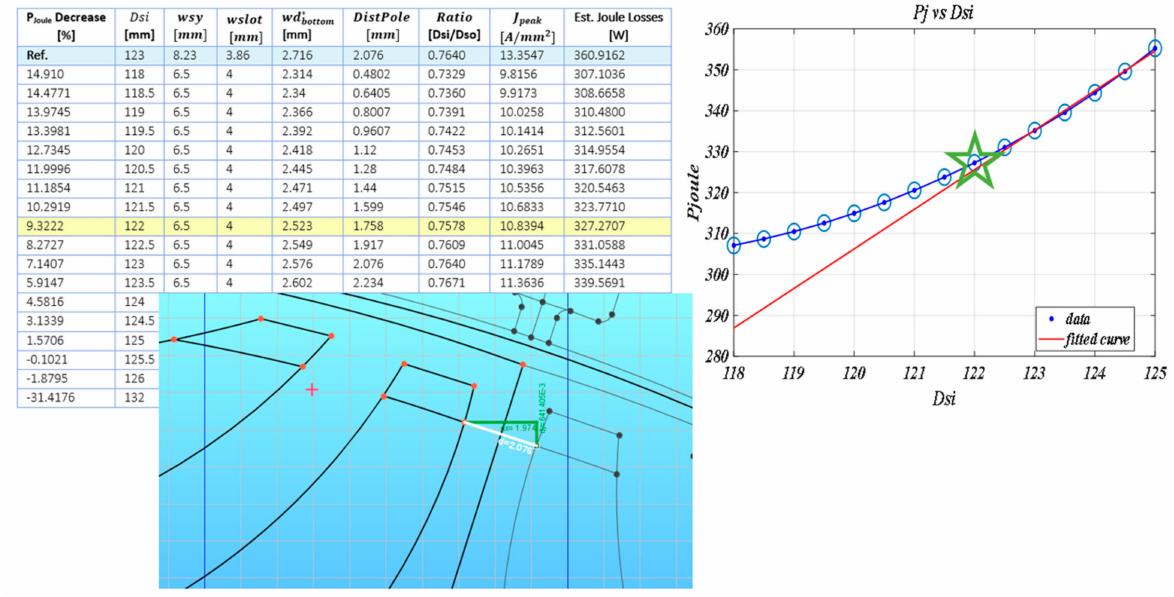
Figure 15. ( Left ) Minimum Joule losses for each D si in the stator optimization results. ( Middle ) Sketch showing the distance between magnet poles for the reference case. ( Right ) Plot of minimum Joule losses for each D si and the selected